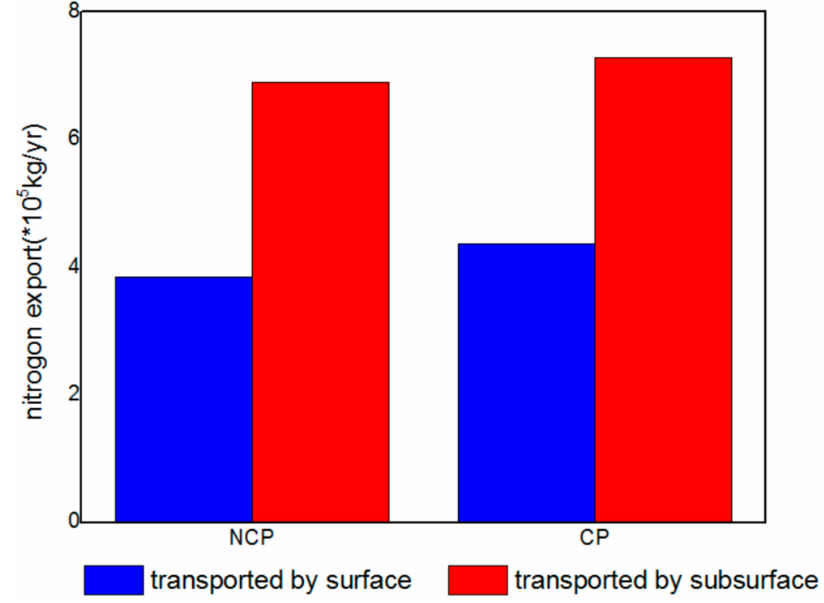
Figure 5. Nitrogen export transported by surface and subsurface in two different scenarios.